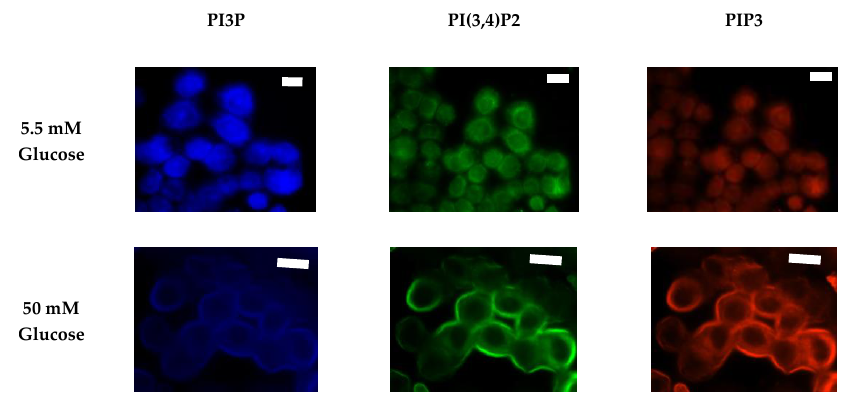
Figure 11. Glucose concentration changes cellular expression of PIPs in TNBC cells. Representative